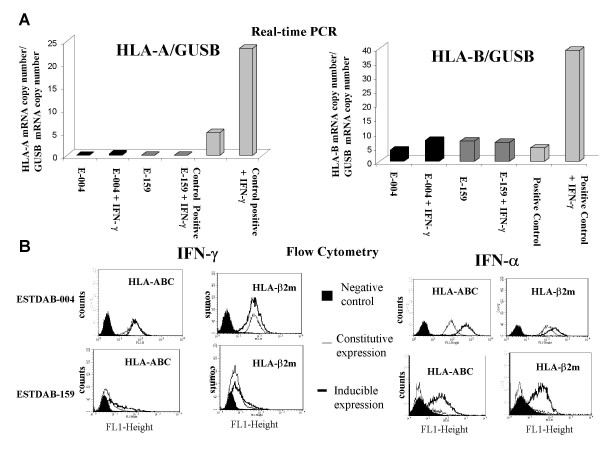
Transcription level (A) and cell surface expression (B) of HLA-ABC molecules in ESTDAB-004 and ESTDAB-159 melanoma cell lines [in (B) examined by indirect immunofluorescence using W6/32 and L-362 mAb]. Cells were treated with 800 U/ml of either IFN-γ or IFN-α for 48 h or with culture medium alone. The dark histogram corresponds to the isotypic control. Panel A – the results of real-time RT-PCR analysis. On the Y-axis on panel A – mRNA copy number of the gene of interest (HLA-A or HLA-B) normalized against the mRNA copy number of the reference gene GUSB.